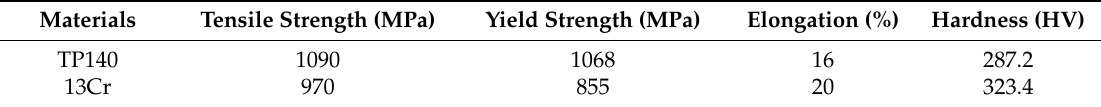
Table 3. Erosion and corrosion conditions for jet experiments.